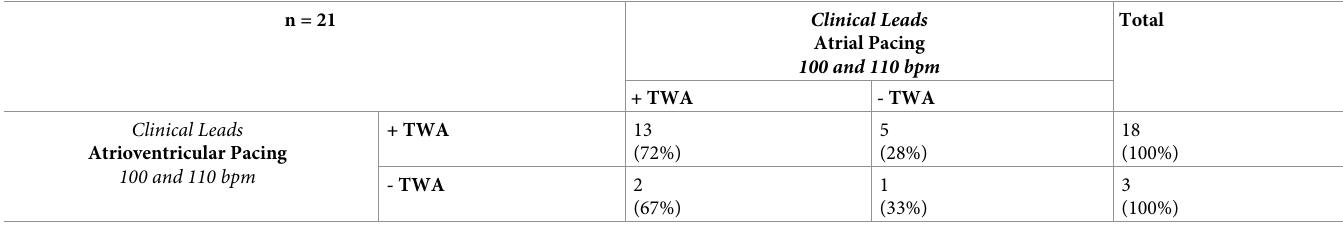
Atrial Pacing 100 and 110 bpm + TWA - TWA 5 (72%) (28%) 1 (67%) (33%)